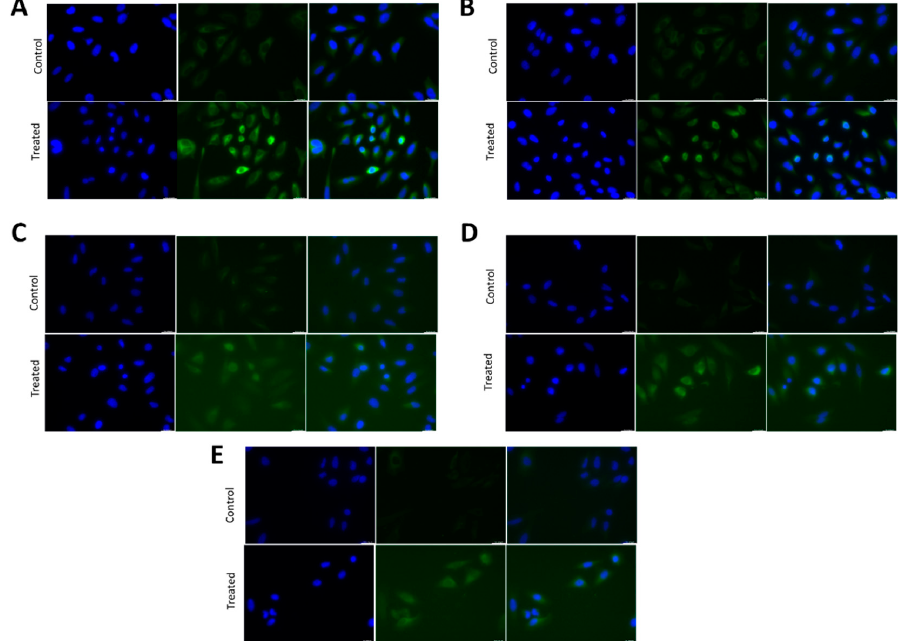
Figure 2. NF- κ B nuclear translocation using TNF α treatment in HeLa cells. ( A–E ) Fluorescent immunostaining of HeLa cells untreated (control) or treated with 10 ng/mL TNF- α for 45 min using antibodies against human RelA/p65 ( A ), RelB ( B ), cRel ( C ), p50 ( D ), p52 ( E ) (green). Nuclei were stained with DAPI (blue).